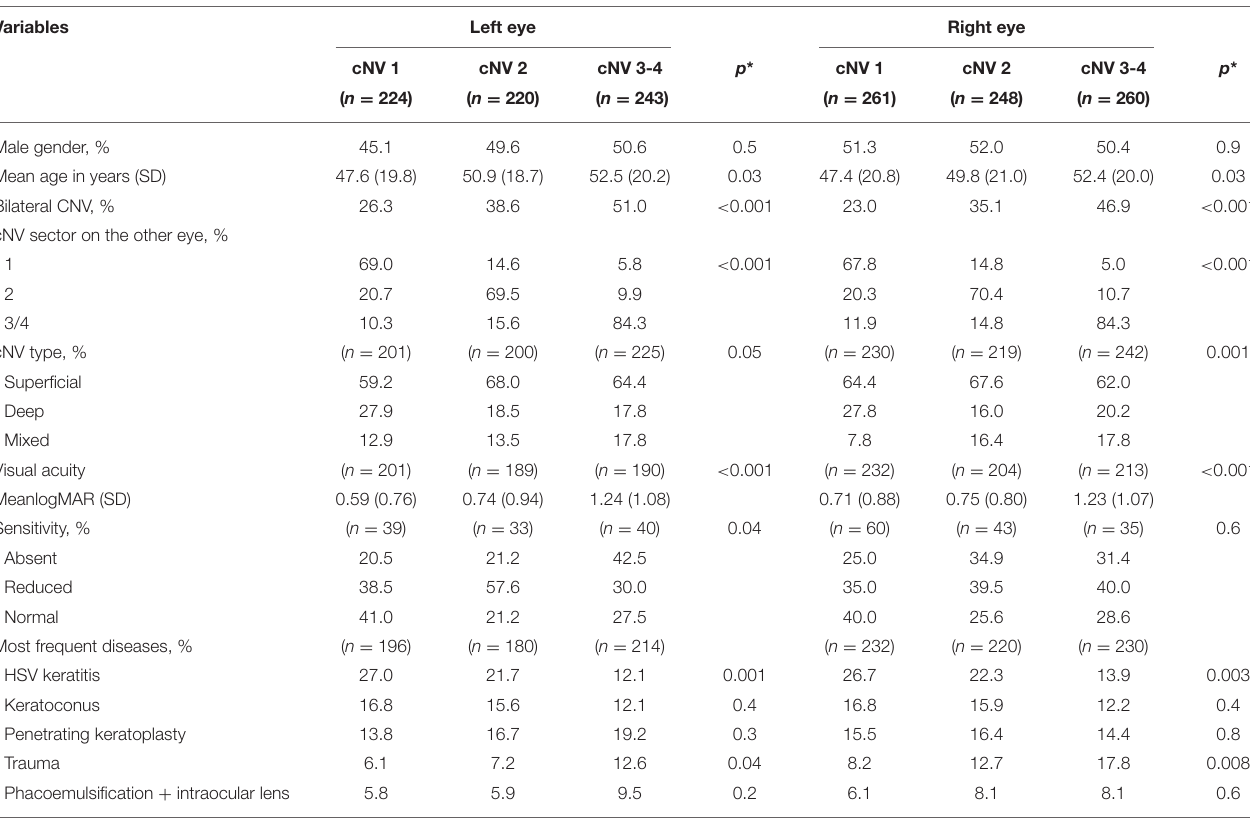
TABLE 3 | Association between corneal neovascularization (cNV) severity and the selected variables: univariate analyses.